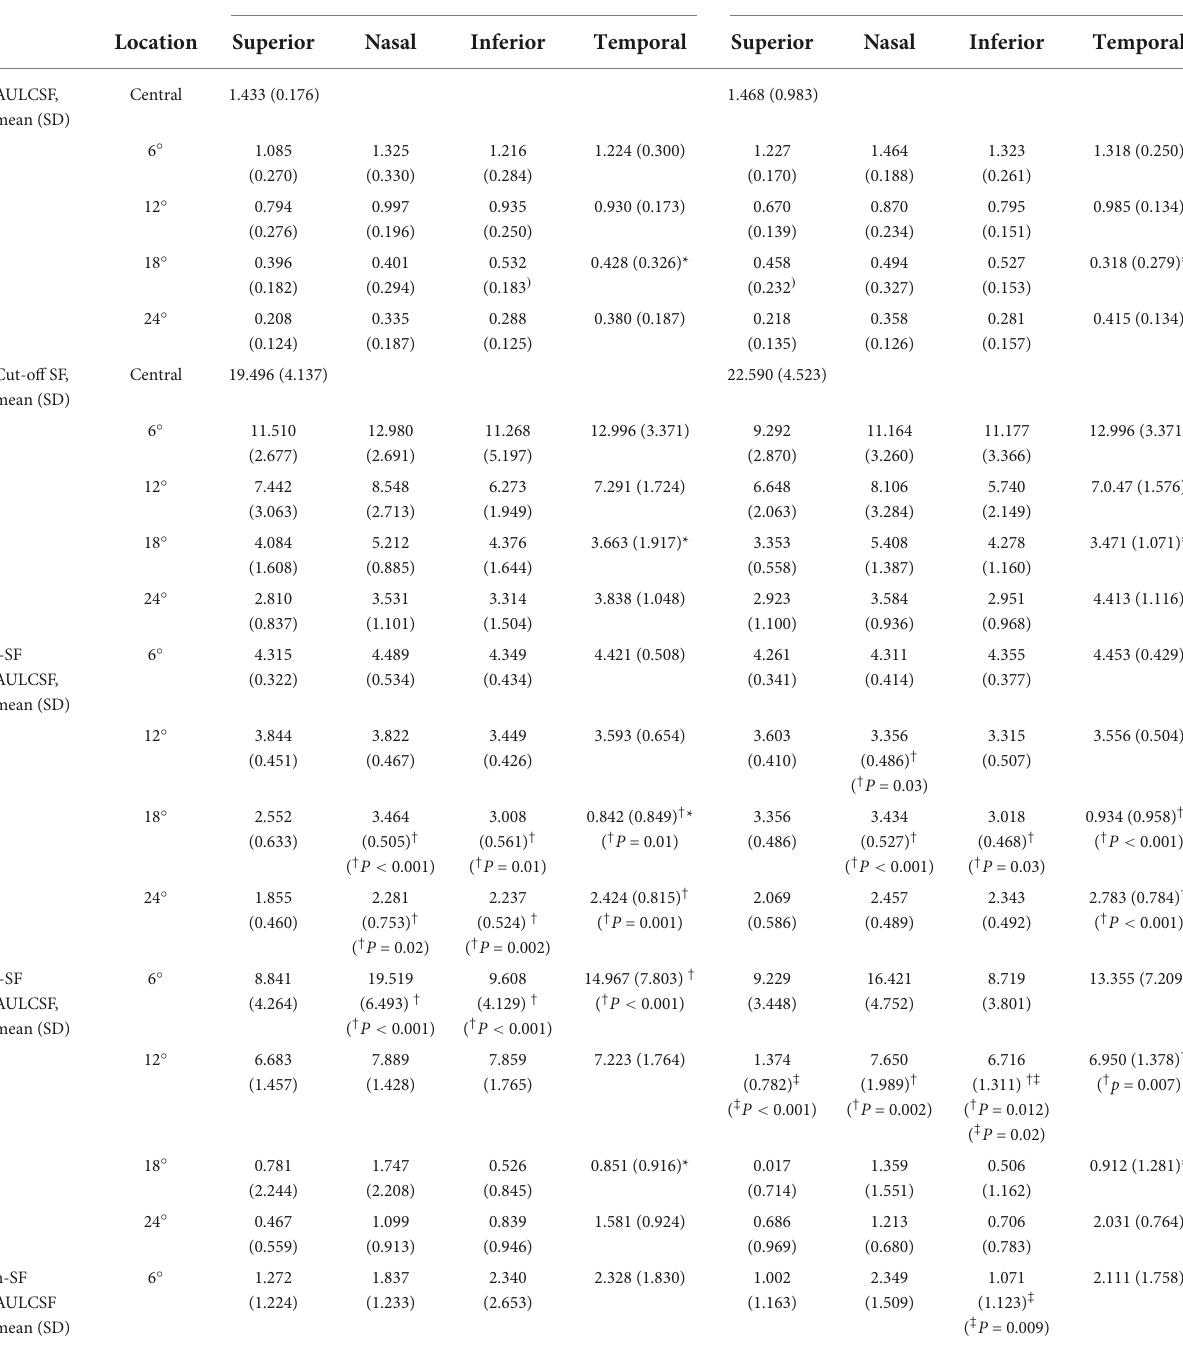
TABLE 3 Summary of CSF